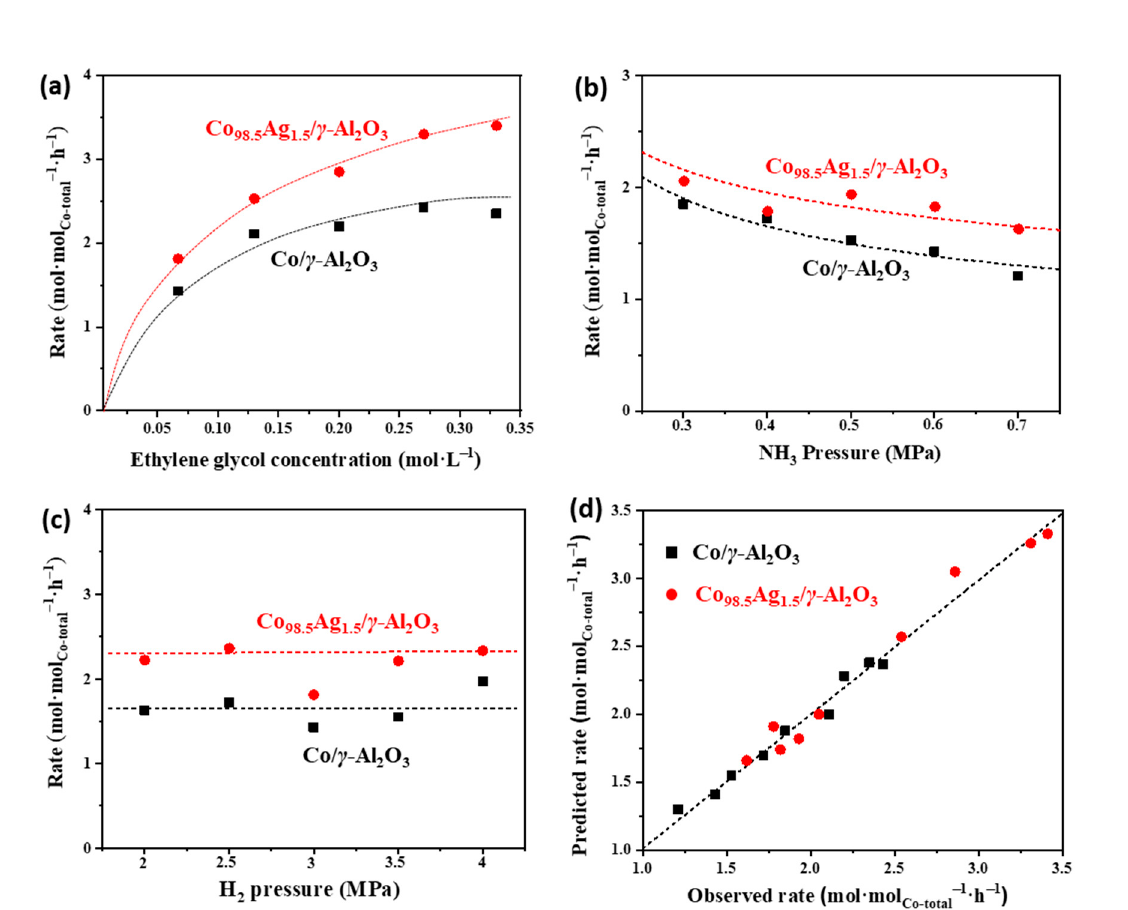
Figure 7. Rates of ethylene glycol concentration on the Co/ γ -Al 2 O 3 and Co 98.5 Ag 1.5 / γ -Al 2 O 3 catalysts (Co 5 wt%) as functions of ( a ) ethylene glycol concentration, ( b ) NH 3 pressure, and ( c ) H 2 pressure (453 K, ∼ 20% ethylene glycol conversion obtained by varying the catalyst amount or reaction time (2–4 h); ( a ) 0.6 MPa NH 3 , 3.0 MPa H 2 ; ( b ) 3.0 MPa H 2, 0.067 mol/L ethylene glycol in tetrahydrofuran solution; ( c ) 0.6 MPa NH 3 , 0.067 mol/L ethylene glycol in tetrahydrofuran solution) . Dashed curves represent regressed fits to the functional form of Equation (1). ( d ) A parity plot for the measured and predicted rates of ethylene glycol amination (Equation (1)) on the Co/ γ -Al 2 O 3 and Co 98.5 Ag 1.5 / γ -Al 2 O 3 catalysts with the regression-fitted parameters shown in Table